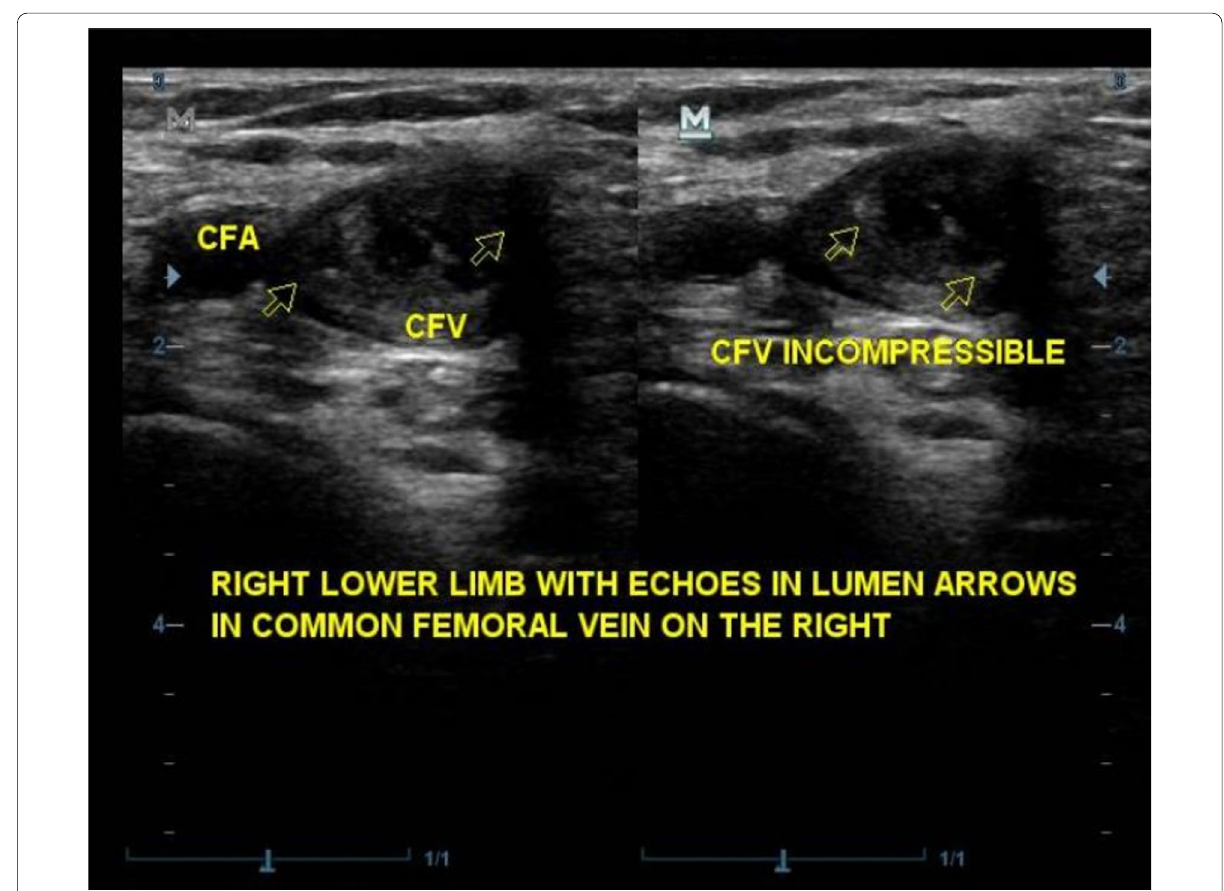
Fig. 6 Sonograms of the right lower limb performed for a 58‑year‑old woman who reported with a three‑day history of significant swelling of the right lower limb and pain, after returning from a long‑distance journey. It shows multiple hyperechoic intraluminal thrombi (yellow hollow arrows) and incompressible right common femoral vein indicative of an acute deep vein thrombosis of the right lower